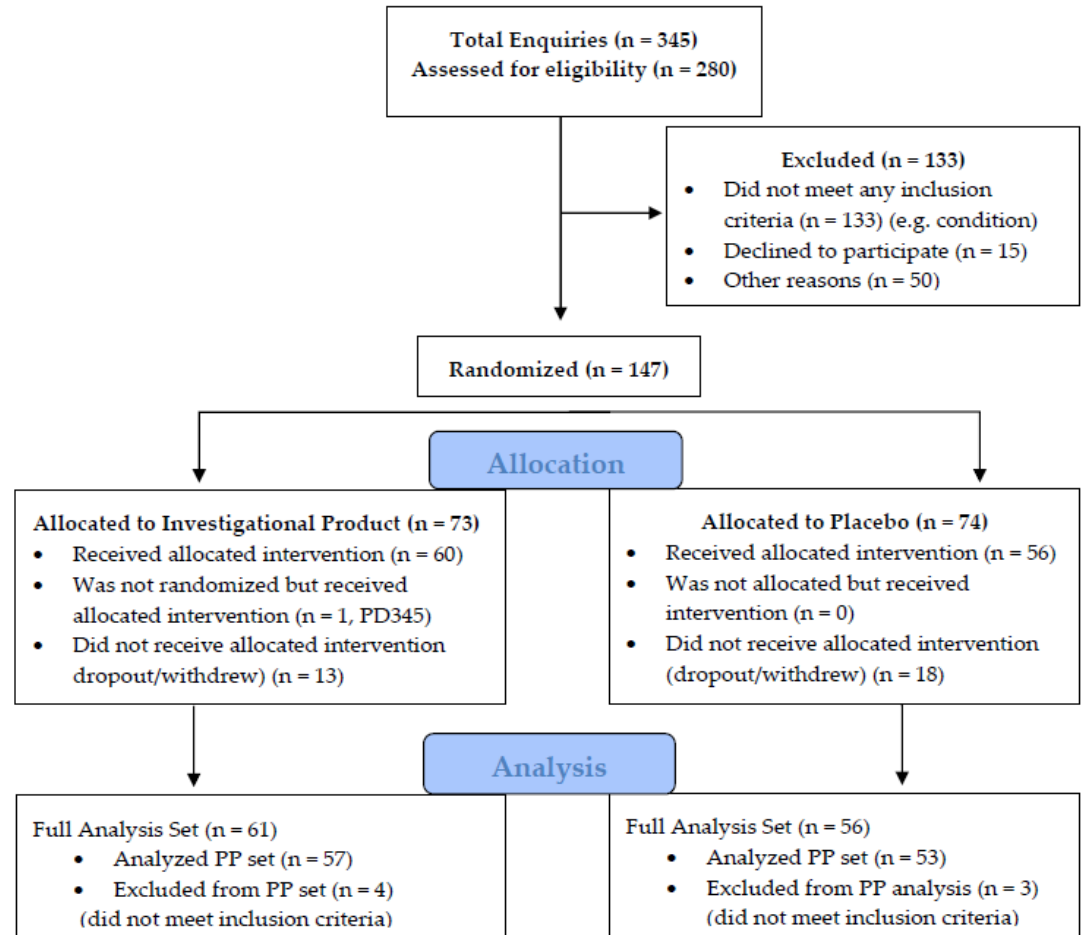
Figure 1. CONsolidated Standards of Reporting Trials (CONSORT) flow diagram of subjects relevant to enquiries—enrolments and randomization.